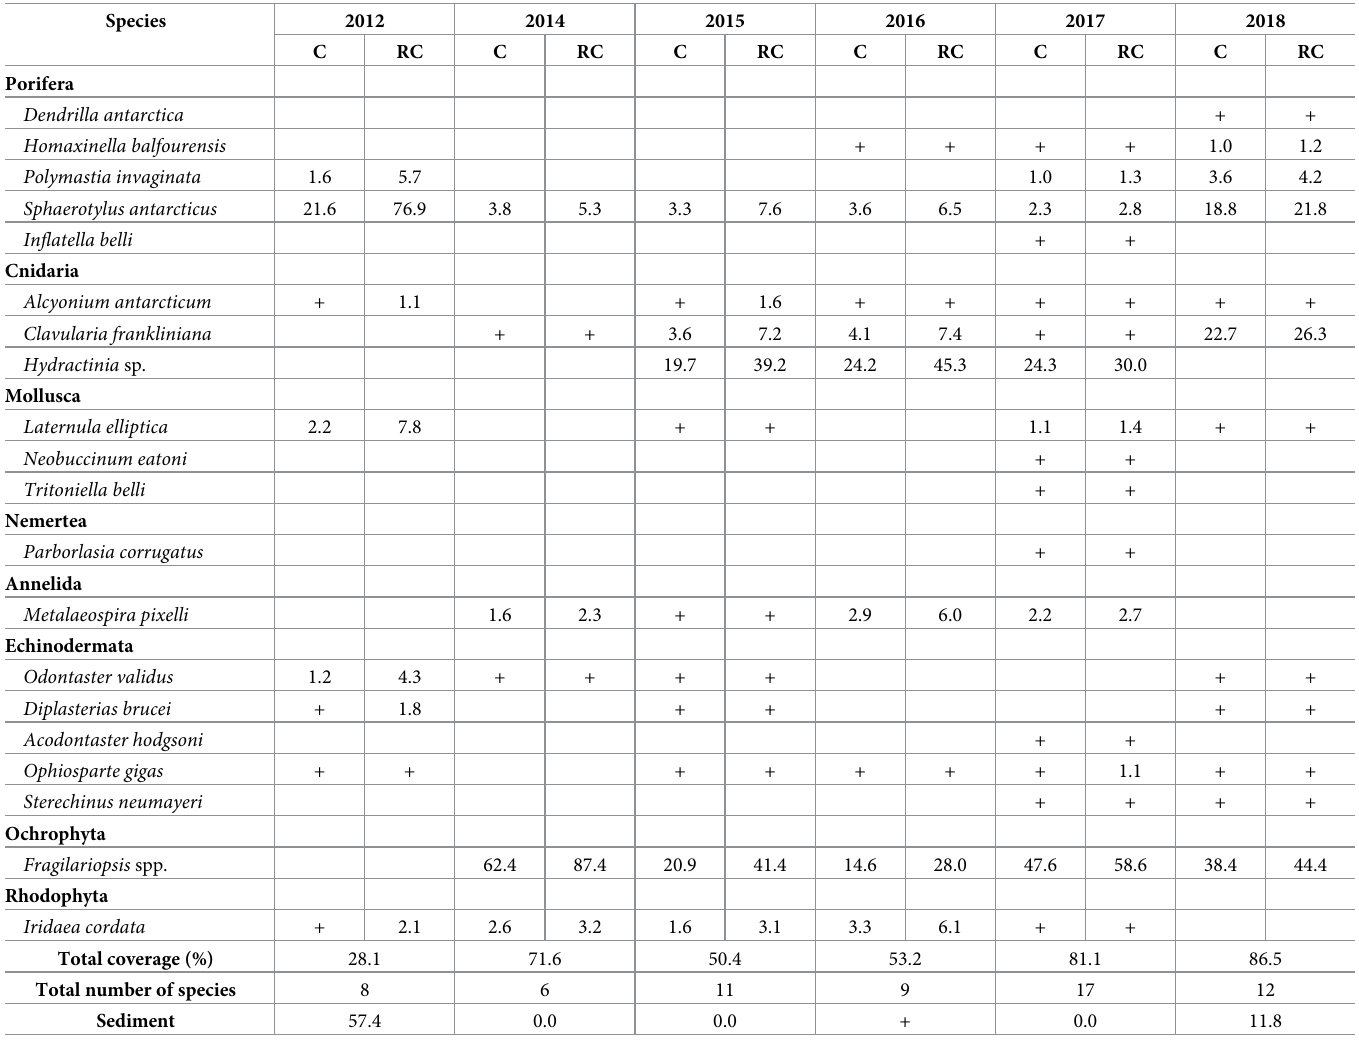
Table 2. List of species with coverage (C) and relative coverage (RC) in Terra Nova Bay during 2012–2018.